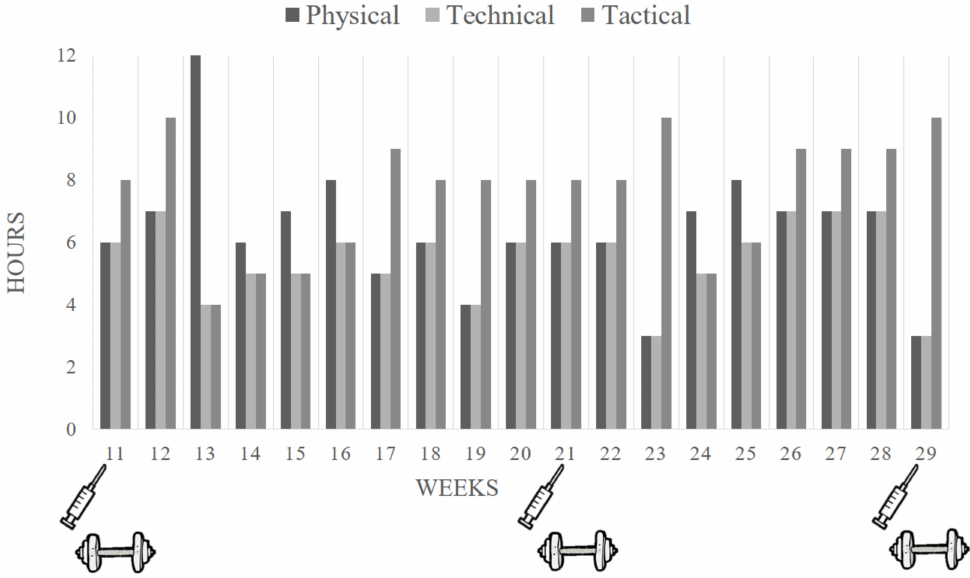
Figure 1. Time and type of training performed by volleyball players in each week of